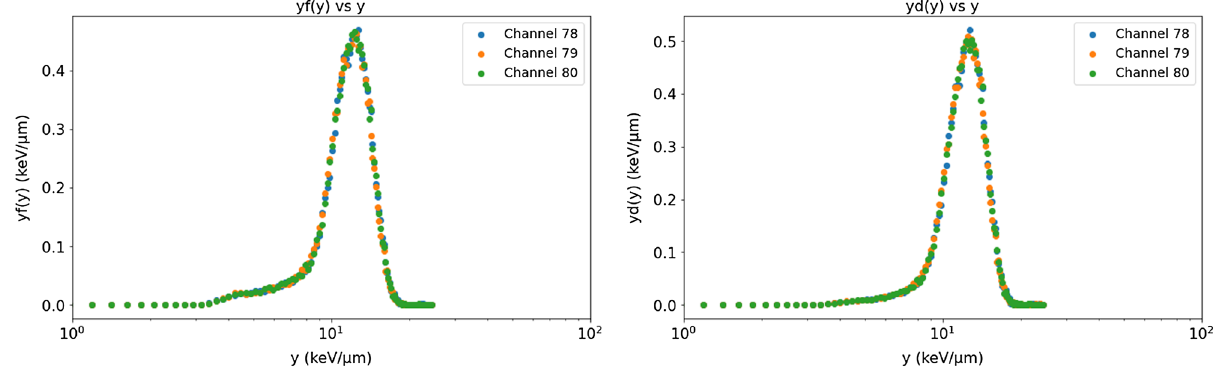
Figure 8. Lineal energy and absorbed dose distributions, f ( y ) and d ( y ), obtained in silicon with three different 3 3 cells (each color in the graphs corresponds to one of the three cells) of the pad-type system under 8 MeV × proton